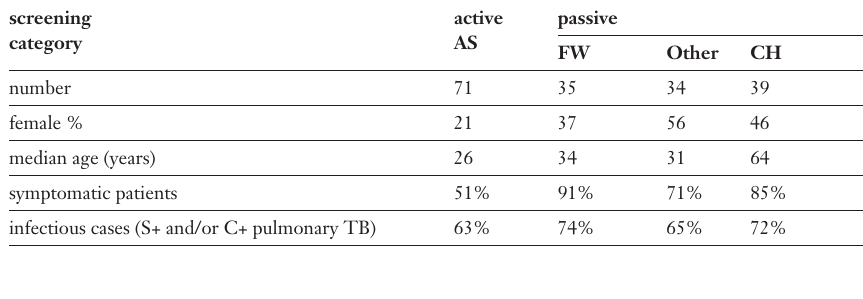
Proportion of and asymptomatic patients, by bacterio- logical result, for the whole group, patients with culture- positive pulmonary TB and smear-posi- tive pulmonary TB (mean with 95% confidence interval).